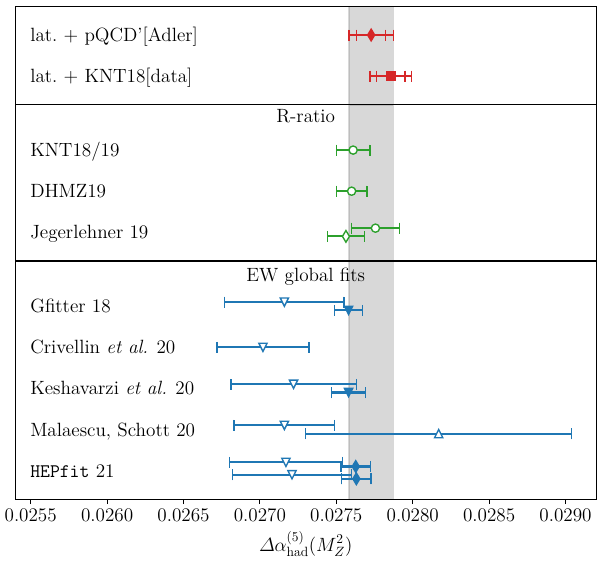
(cid:0) (cid:1) M 2 . The first two data points (red symbols) Z had (cid:0) (cid:1) − Q 2 . 0 had